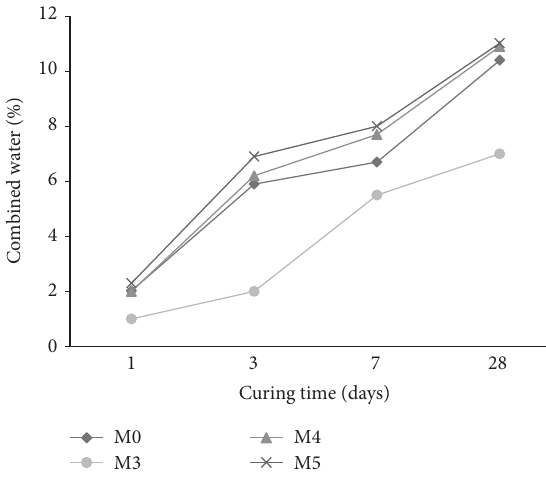
Figure11:Theeffectofcosurfactantsonthecombinedwatercontent of mortar. Figure 12: The effect of copolymer latexes prepared in presence of DBSS/PVA on the combined water content of mortar.